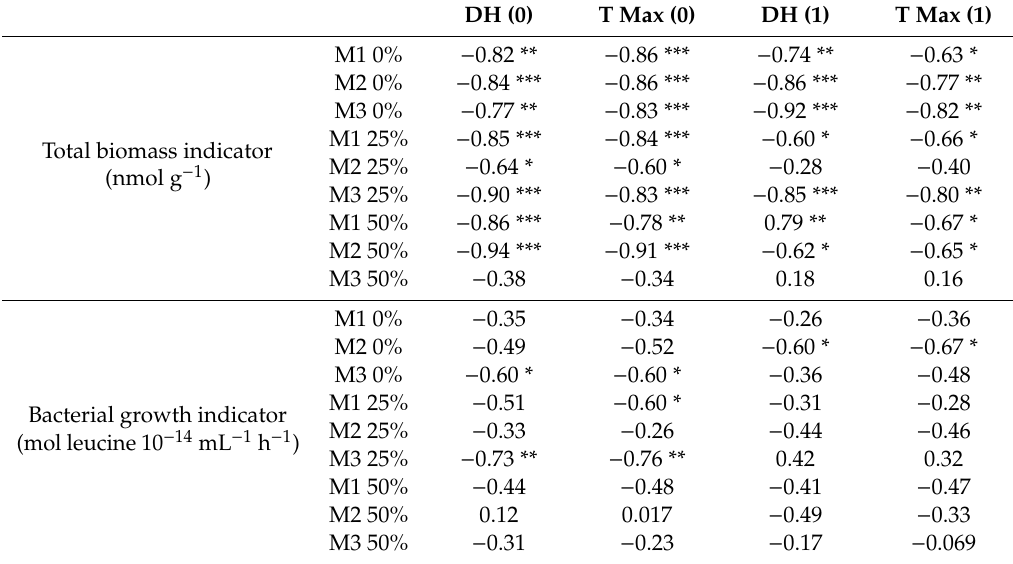
Table 6. Correlation between the degree-hours with the total biomass values for the three di ff erent soil mixtures (M1, M2 and M3) with di ff erent initial water content (0, 25 and 50%) immediately (0) and one month after the heating (1). Significance codes: *** p < 0.001; ** p < 0.01; * p <